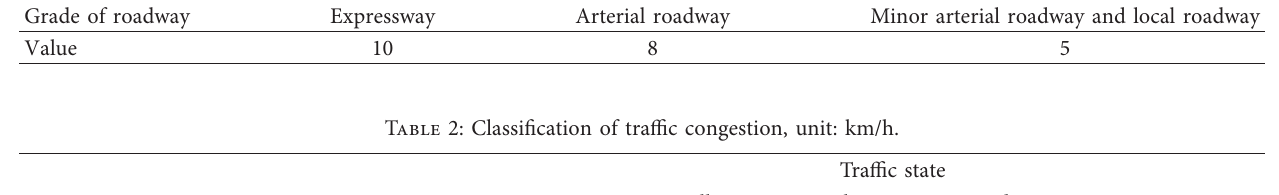
Table 1: Weight value corresponding to each grade of roadway section.